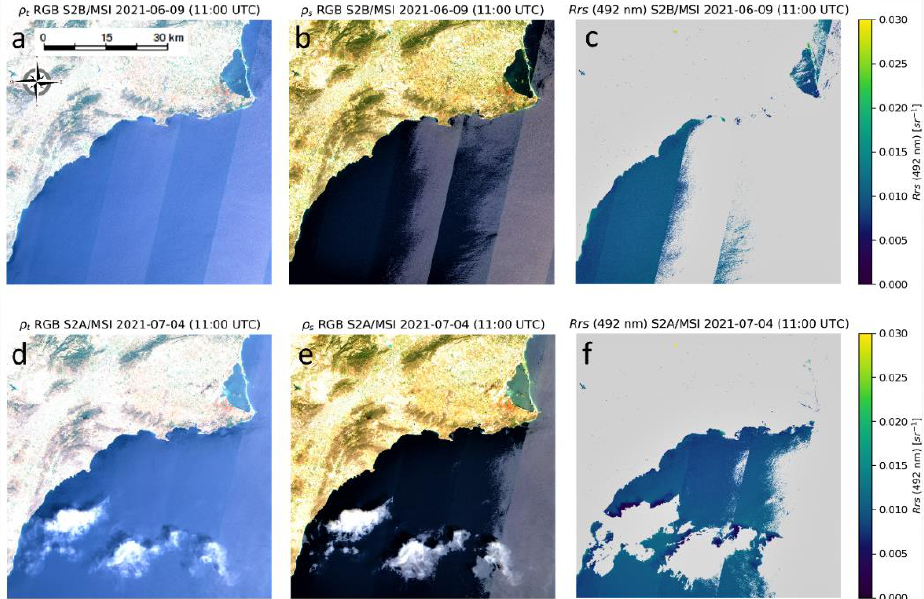
Figure 6. RGB (Red – Green – Blue) composite image on 9 June 2021 from the Sentinel-2 satellite (10 m spatial resolution) at ( a ) top-of-atmosphere (TOA) level, ( b ) bottom-of-atmosphere (BOA) level after ACOLITE, and ( c ) remote sensing reflectance (Rrs, sr −1 ) of the blue band (492 nm); ( d – f ) the same on 4 July 2021. Severe sunglint contamination can be clearly observed in the eastern section of the Sentinel-2 tile affecting Mar Menor.